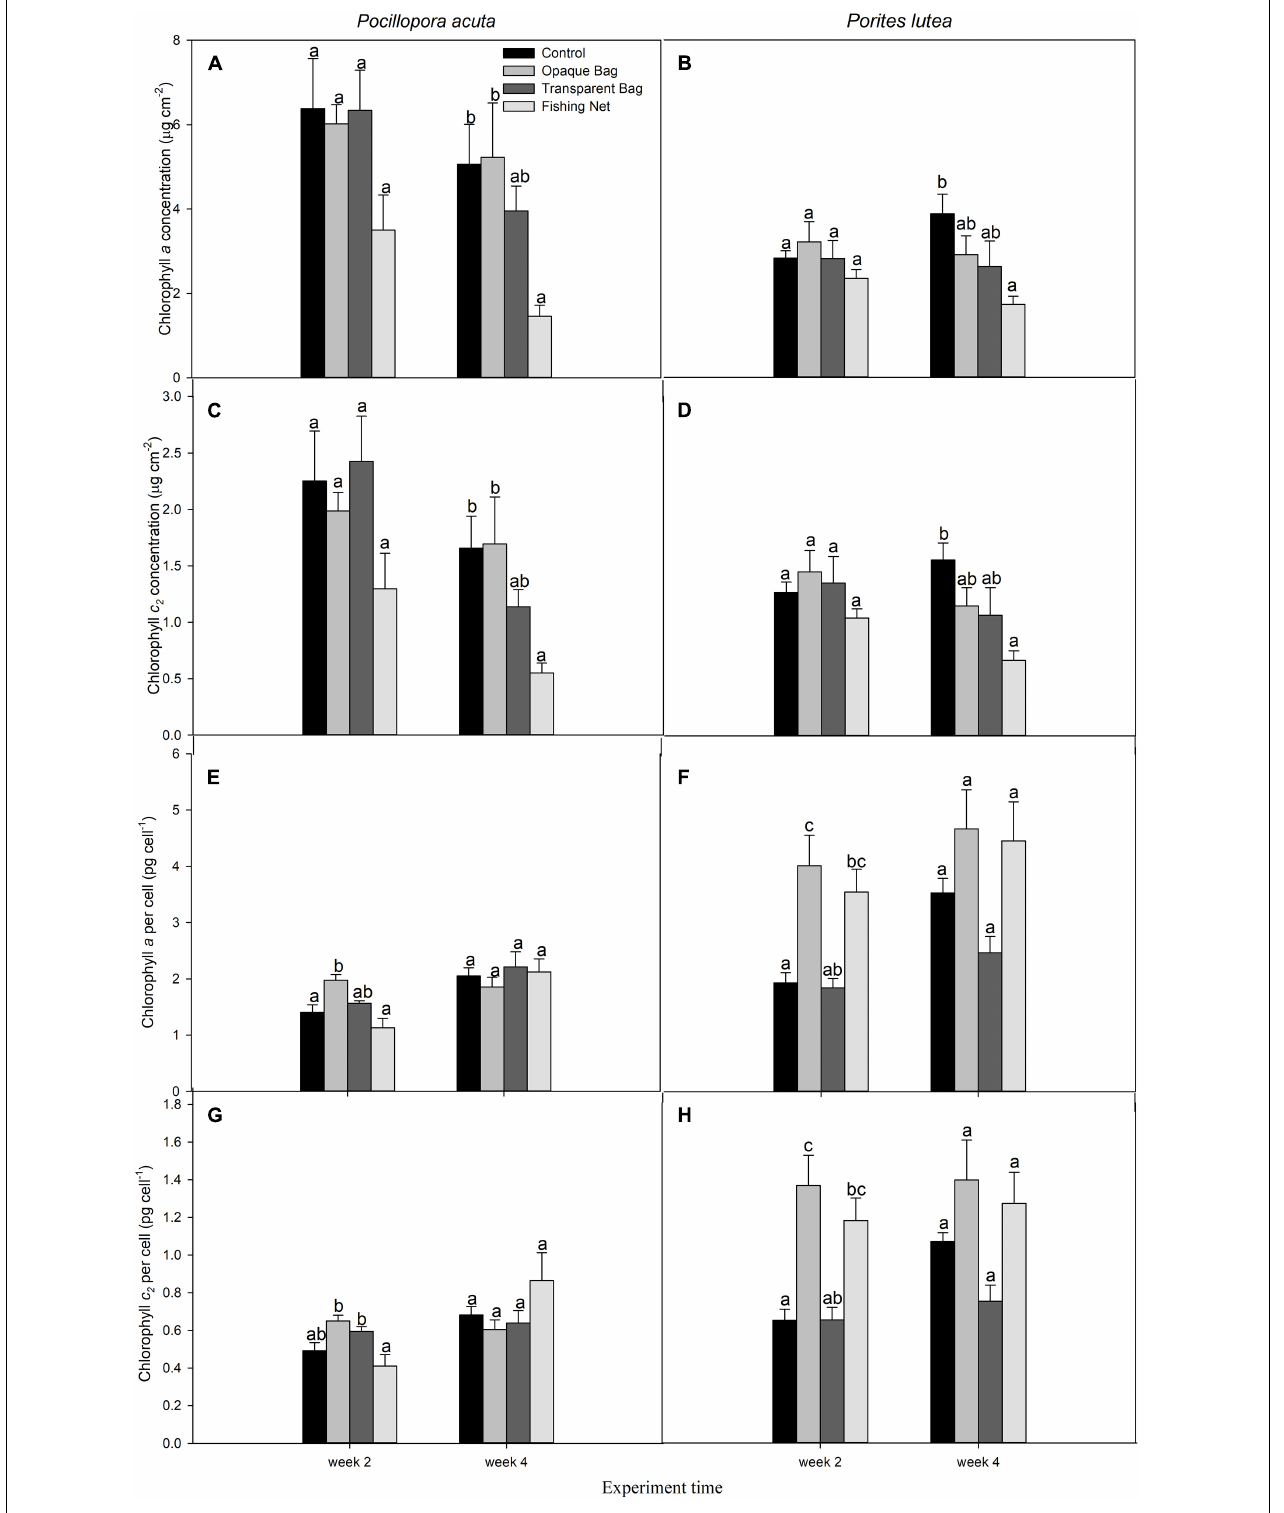
FIGURE 5 | Chlorophyll a concentration ( µ g cm − 2 ; A,B ), chlorophyll c 2 concentration ( µ g cm − 2 ; C,D ), cellular chlorophyll a concentration (pg cell − 1 ; E, F) , and cellular chlorophyll c 2 concentration (pg cell − 1 ; G,H ) of P. acuta (left column chart) and P. lutea (right column chart) subjected to treatments, at week 2 and week 4. Data are presented as Mean ± SE ( n = 6). ). a, b, and c indicate significant difference.